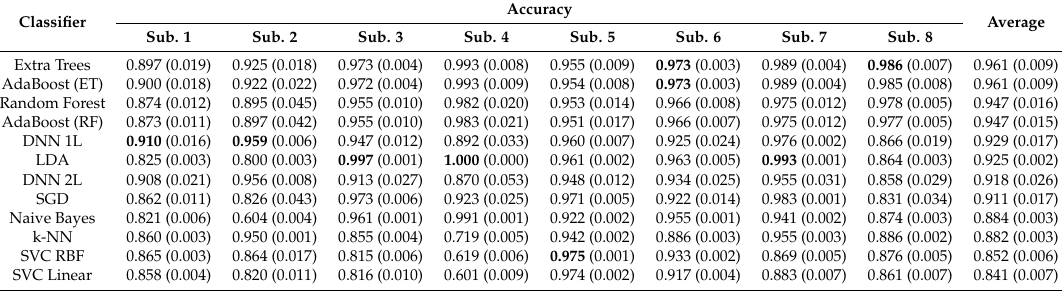
Figure 6. The distribution of accuracies along 50 runs for each classifier. The data represent the average accuracies for all subjects. The results were obtained by training each model 50 times per subject with 5% of the training data, using LOSO cross-validation. Table 5. Average accuracy (and standard deviation) for each classifier and subject when using 5% of the training data. The bold text indicates the classifiers that outperformed others for each subject. ET, extra trees; RF, random forest; SGD, stochastic gradient